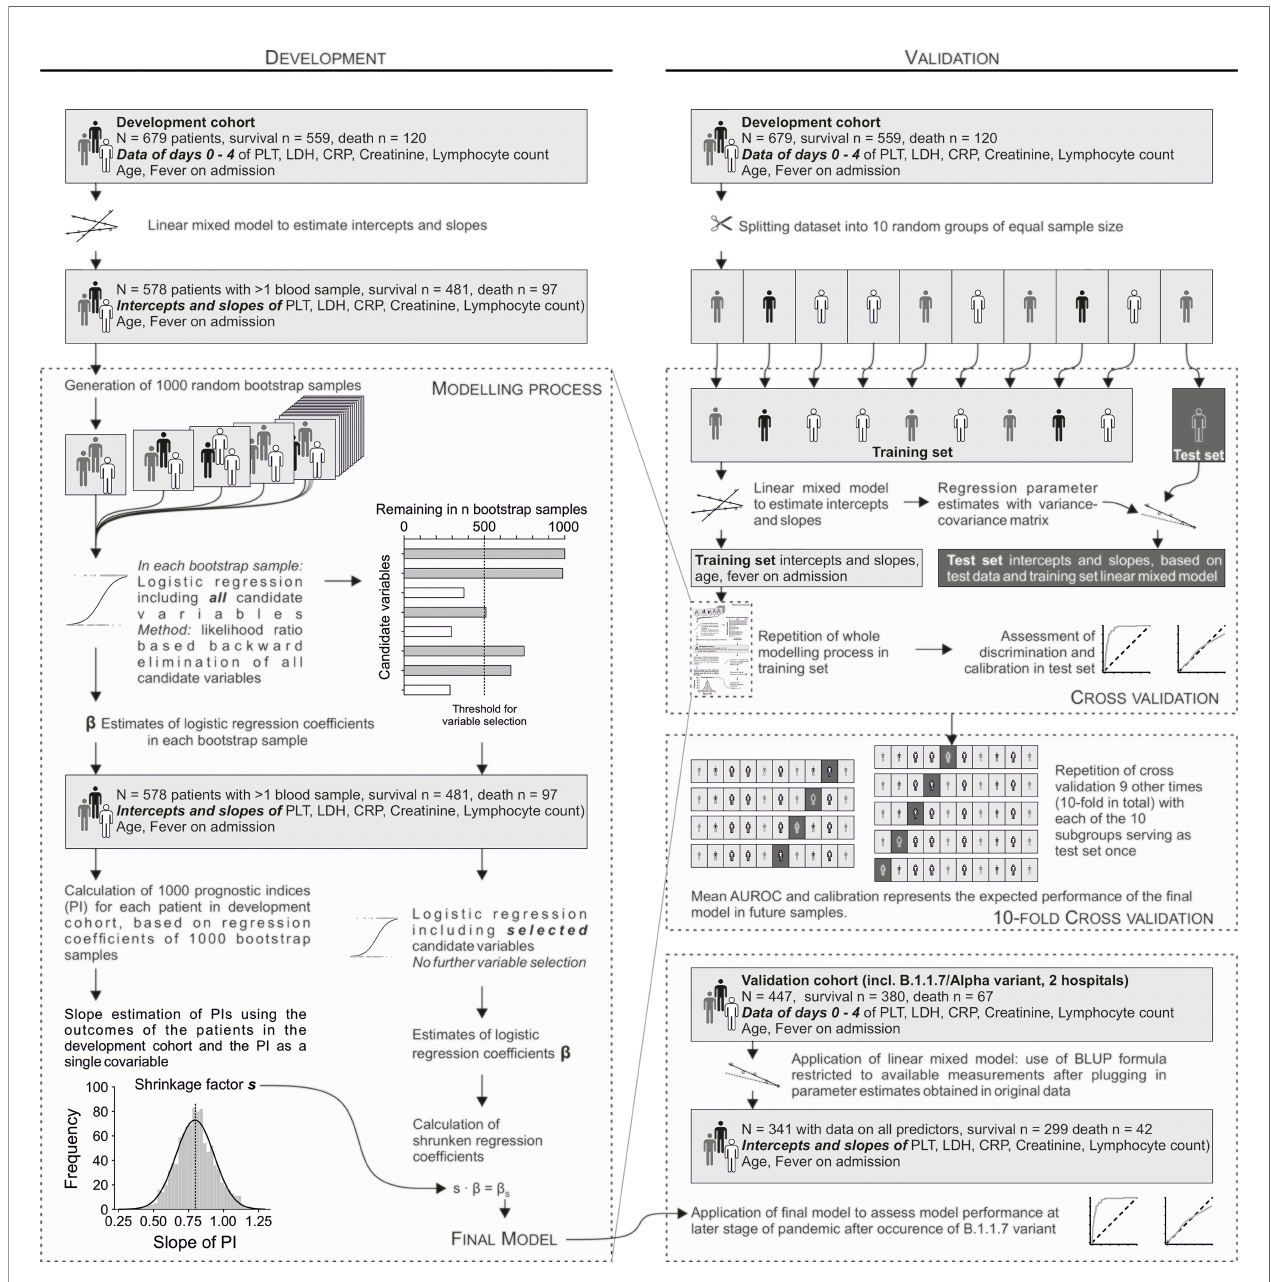
FIGURE 1 | Model development and validation